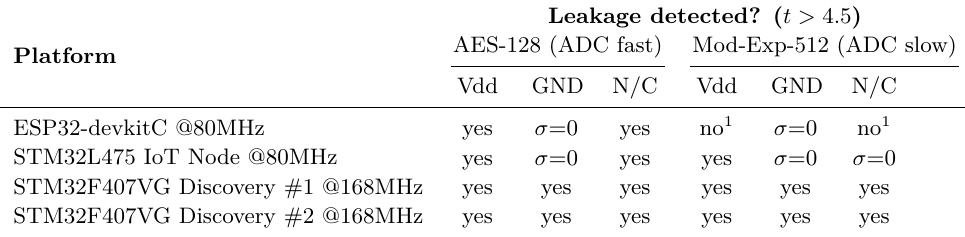
Table 3: Overview of Leakage Assessment over all tested Platforms and Configurations; ADC connected to {Vdd, GND, not connected (N/C)}. Amount of collected traces are 100k for modular exponentiation, and 1M for AES. The ADC was noise-free when σ